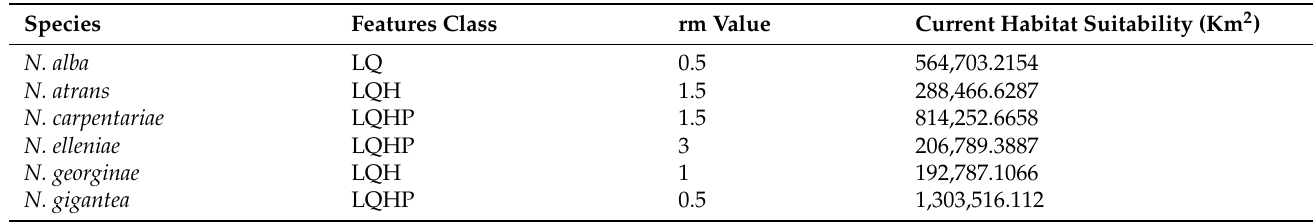
Table 2. Feature classes selected for the modeling of the Nymphaea species in